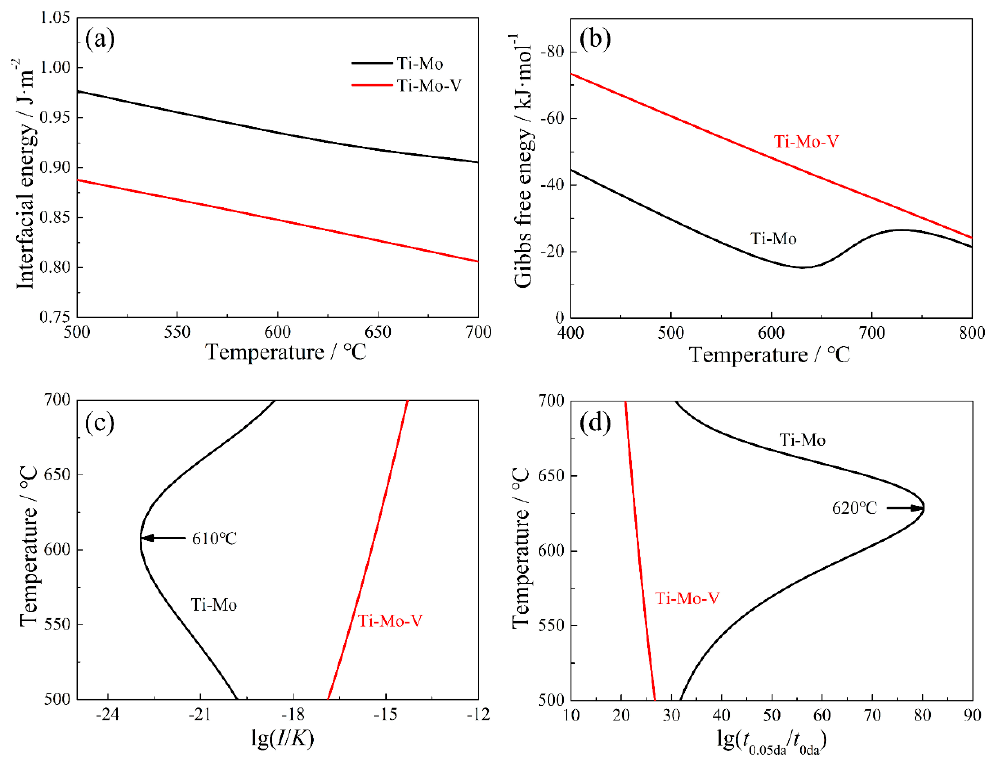
Figure 10. The thermodynamic and kinetic analysis in ferrite of Ti − Mo and Ti − Mo − V steels. ( a ) curve of interfacial energy, ( b ) curve of Gibbs free energy, ( c ) curve of NrT and ( d ) curve of PTT.